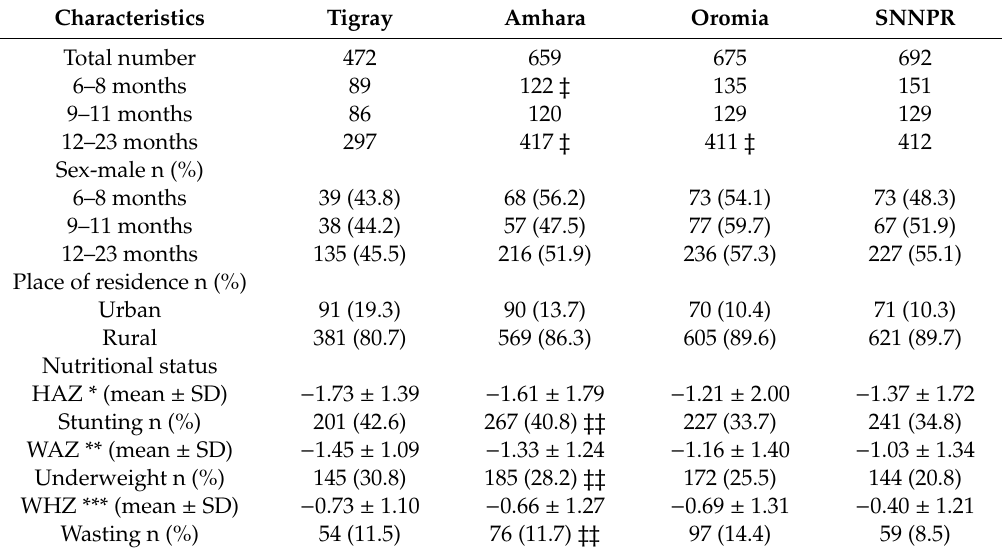
Table 2. Characteristics of study children by age group and region in four regions in